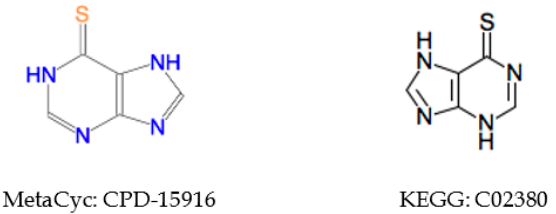
Figure 6. Compound with different aromatic representations. These two corresponding compound entries across KEGG and MetaCyc have two different aromatic substructure representations.